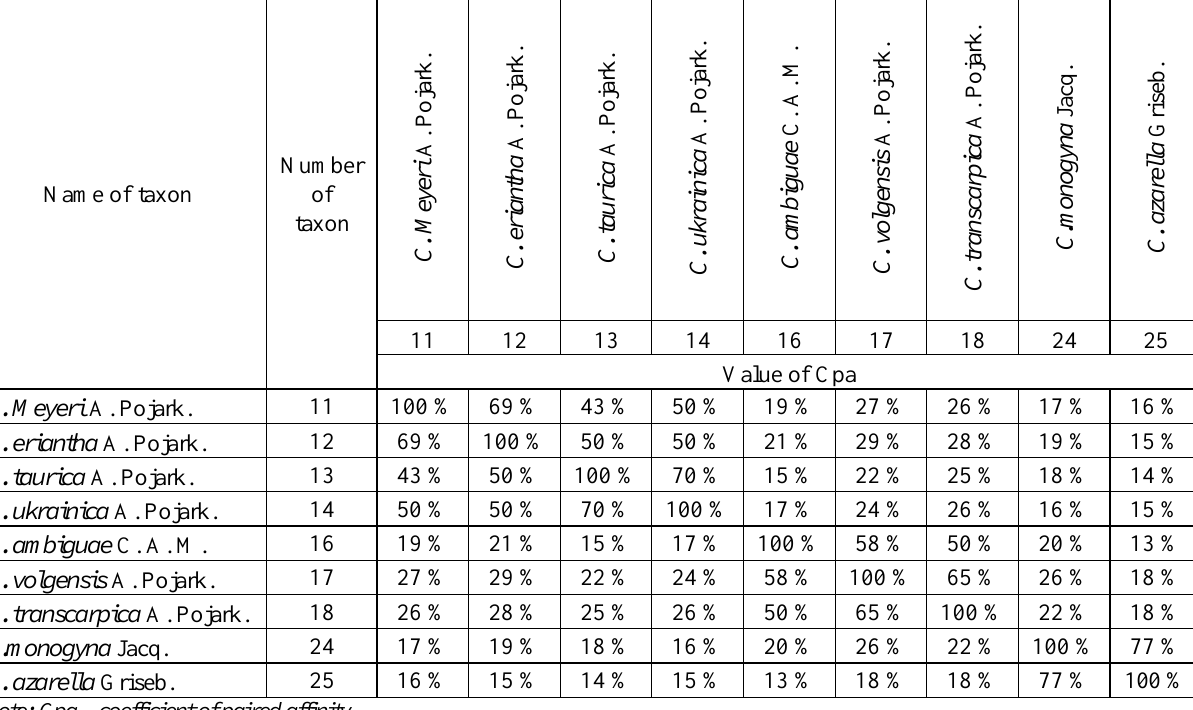
The interconnections between taxones of the main groups of Oxyacanthae Zbl. section according to vegetative features